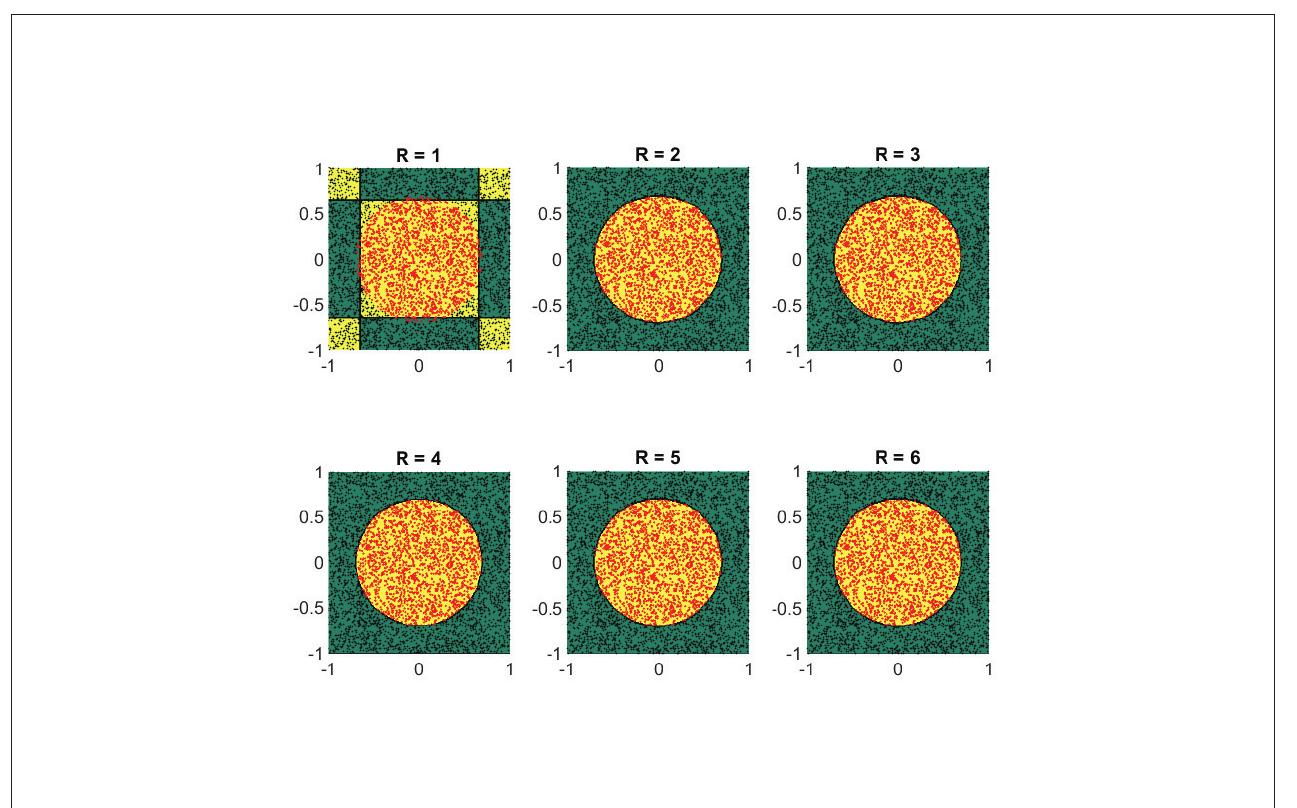
FIGURE 8 | For a simple circular shaped classification set, two separable terms suffice for a good classification. Shown are the obtained results on a synthetic dataset by using the logistic loss function (Equation 22). The recovered classification sets are marked by the yellow and green contours, whereas the labeled data used for training are marked by red and black